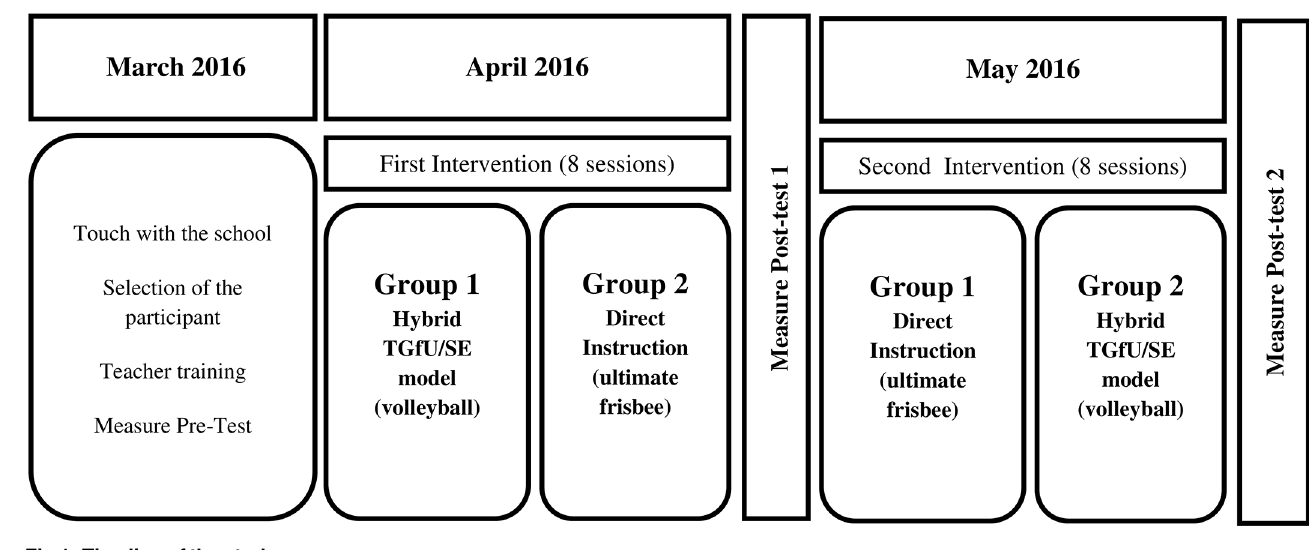
Fig 1. Timeline of the